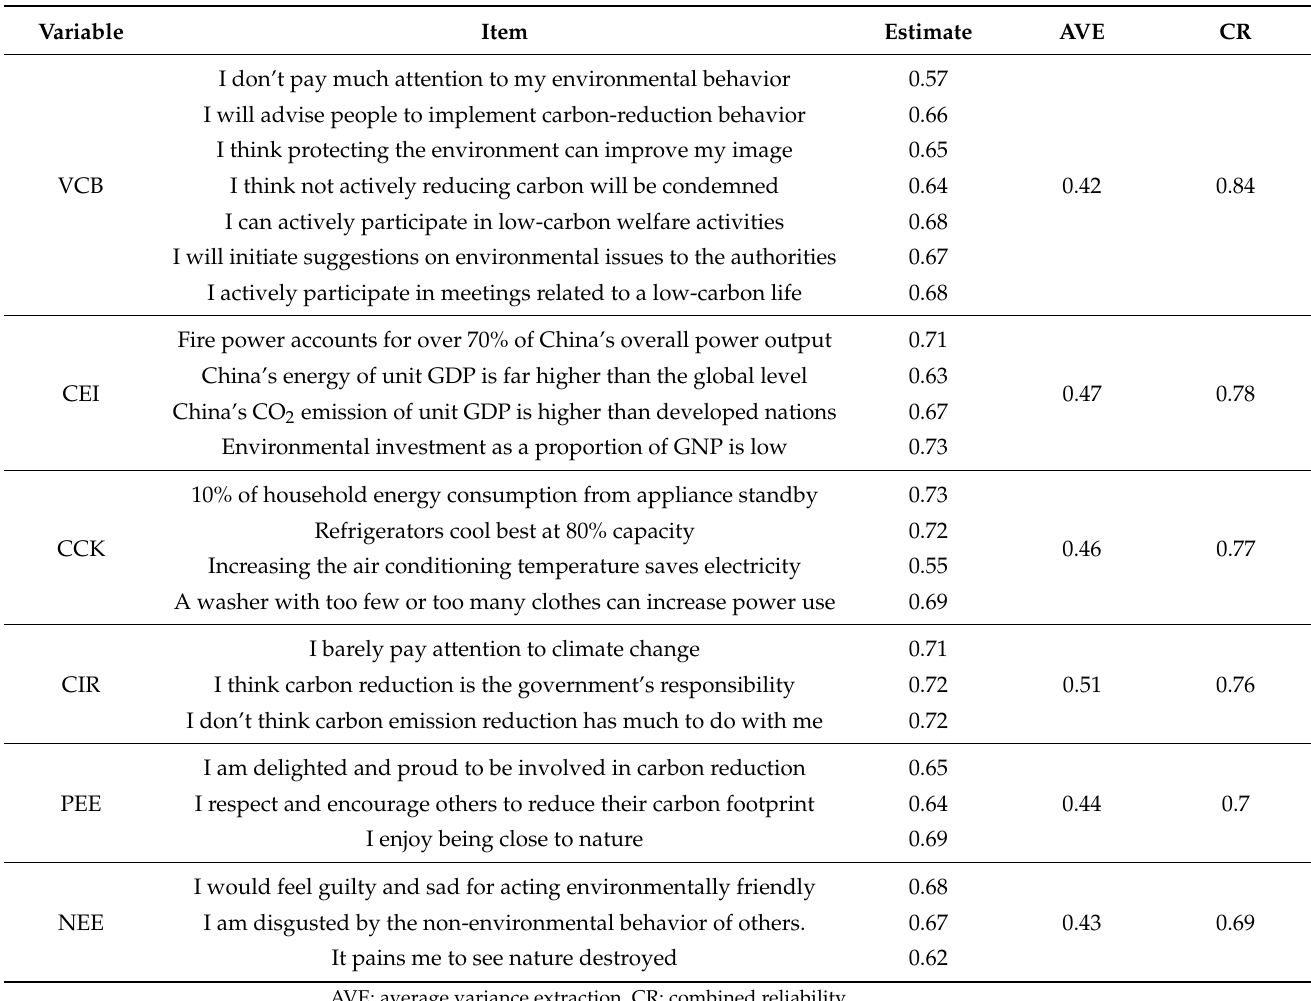
Table 2. Reliability and convergent validity analysis.